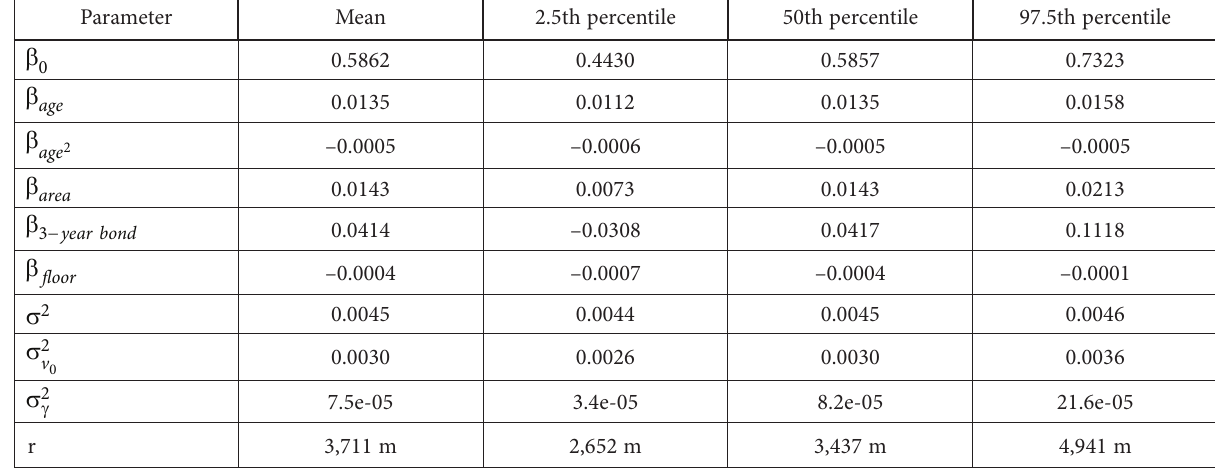
Table 4. Model fit